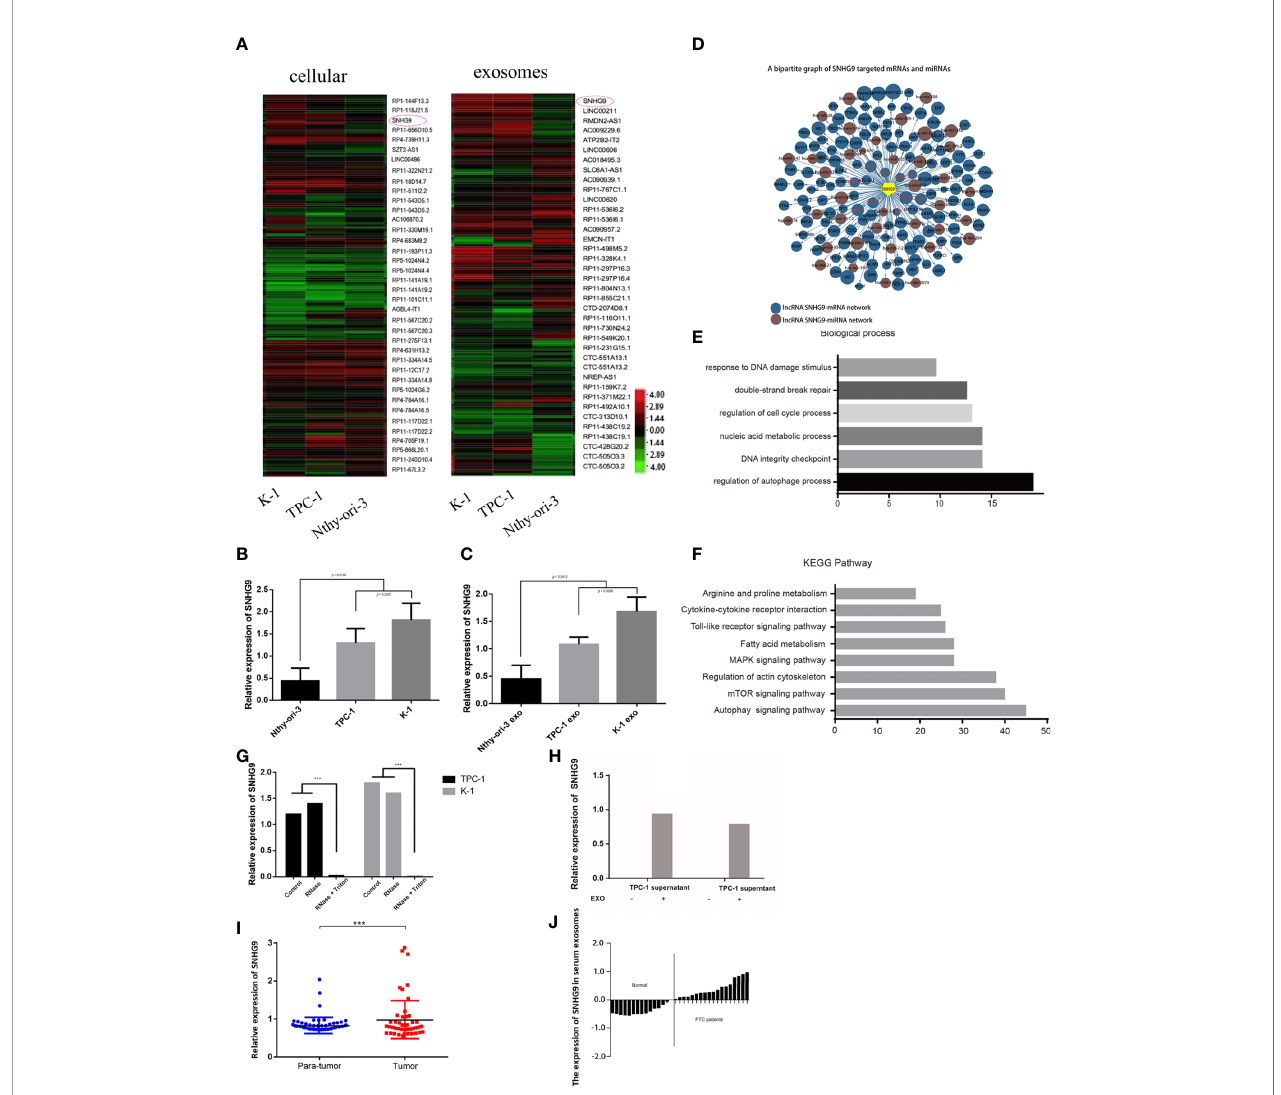
FIGURE 1 | Identi fi cation and expression of PTC cell exosome-enriched lncRNA SNHG9. (A) High-throughput screening identi fi cation of PTC associated exosome lncRNAs. SNHG9 is PTC cell exosome-enriched lncRNA in TPC-1 and K-1 cells compared with Nthy-ori-3 cell. (B, C) Validation of SNHG9 overexpression in both TPC-1 and K-1 cells and their respective exosomes compared with Nthy-ori-3 cell and its exosome by qPCR. (D) Coregulation network of SNHG9 with mRNA/ miRNA. SNHG9 had an interaction with autophagy related molecules. (E) Gene ontology enrichment analysis showed the highest regulation scores in autophagy and apoptosis. (F) KEGG-pathway-weighted analysis showed SNHG9 mainly targeted apoptosis and autophagy pathways. (G) SNHG9 in the PTC cell supernatant mainly derived from cell exosomes. QPCR showed signi fi cantly lower SNHG9 expression level in supernatant treated with Rnase and Triton compared with supernatant treated with only Rnase and control group. (H) QPCR con fi rmed no SNHG9 expression in cell supernatants after exosome extraction. (I) SNHG9 expression level between tumor and normal tissues in 70 PTC patients from FUSCC. The results were normalized to b -actin mRNA level. (J) Waterfall plot showed the distribution of SNHG9 expression level in each PTC patients from FUSCC. ***P < 0.001, data were pooled from three independent experiments. FUSCC, Fudan University Shanghai Cancer Center; PTC, papillary thyroid